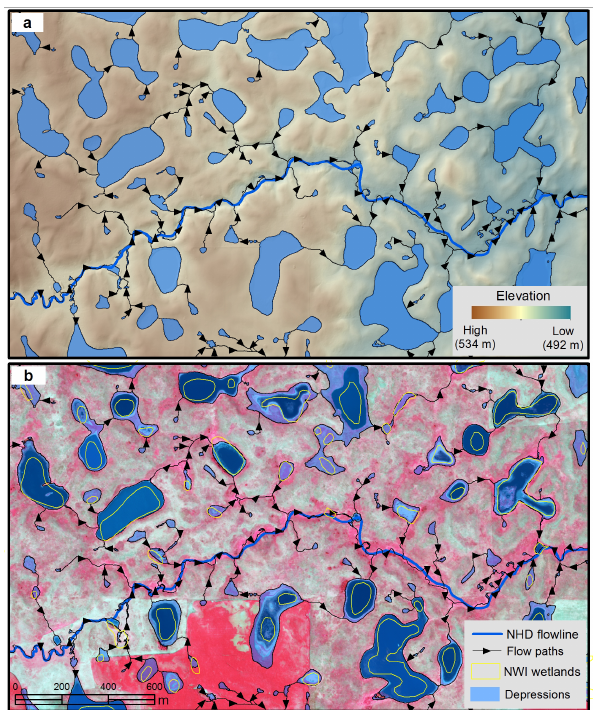
Figure 9. Examples of lidar-derived wetland depressions and flow paths in the Pipestem subbasin (image location: 47 ◦ 1 (cid:48) 32.679 (cid:48)(cid:48) N, 98 ◦ 59 (cid:48) 48.82 (cid:48)(cid:48) W ). (a) Wetland depressions and flow paths overlaid on lidar shaded relief map; (b) NWI polygons, wetland depressions, and flow paths overlaid on color infrared aerial photograph